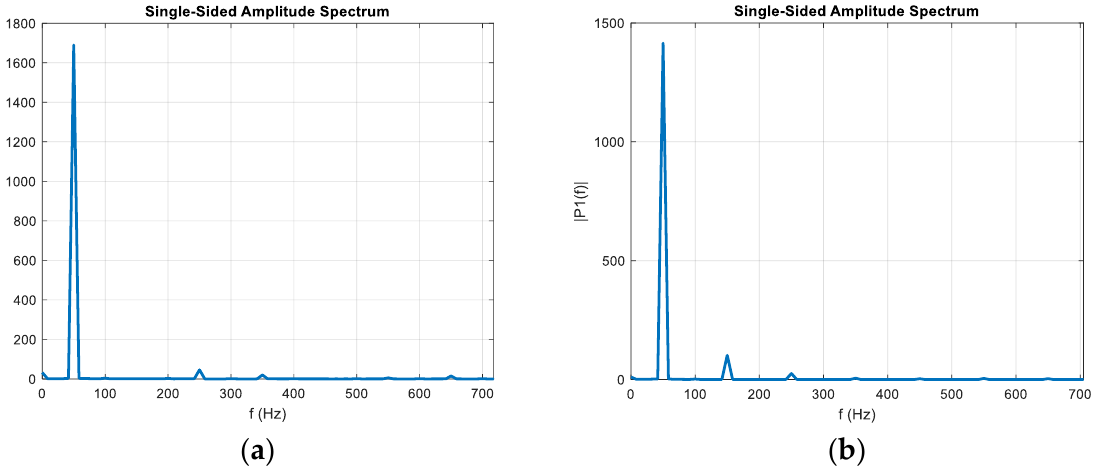
Figure 15. Harmonic distortion of the currents phase A: ( a ) without controlled choke (THD = 0.2%) ( b )